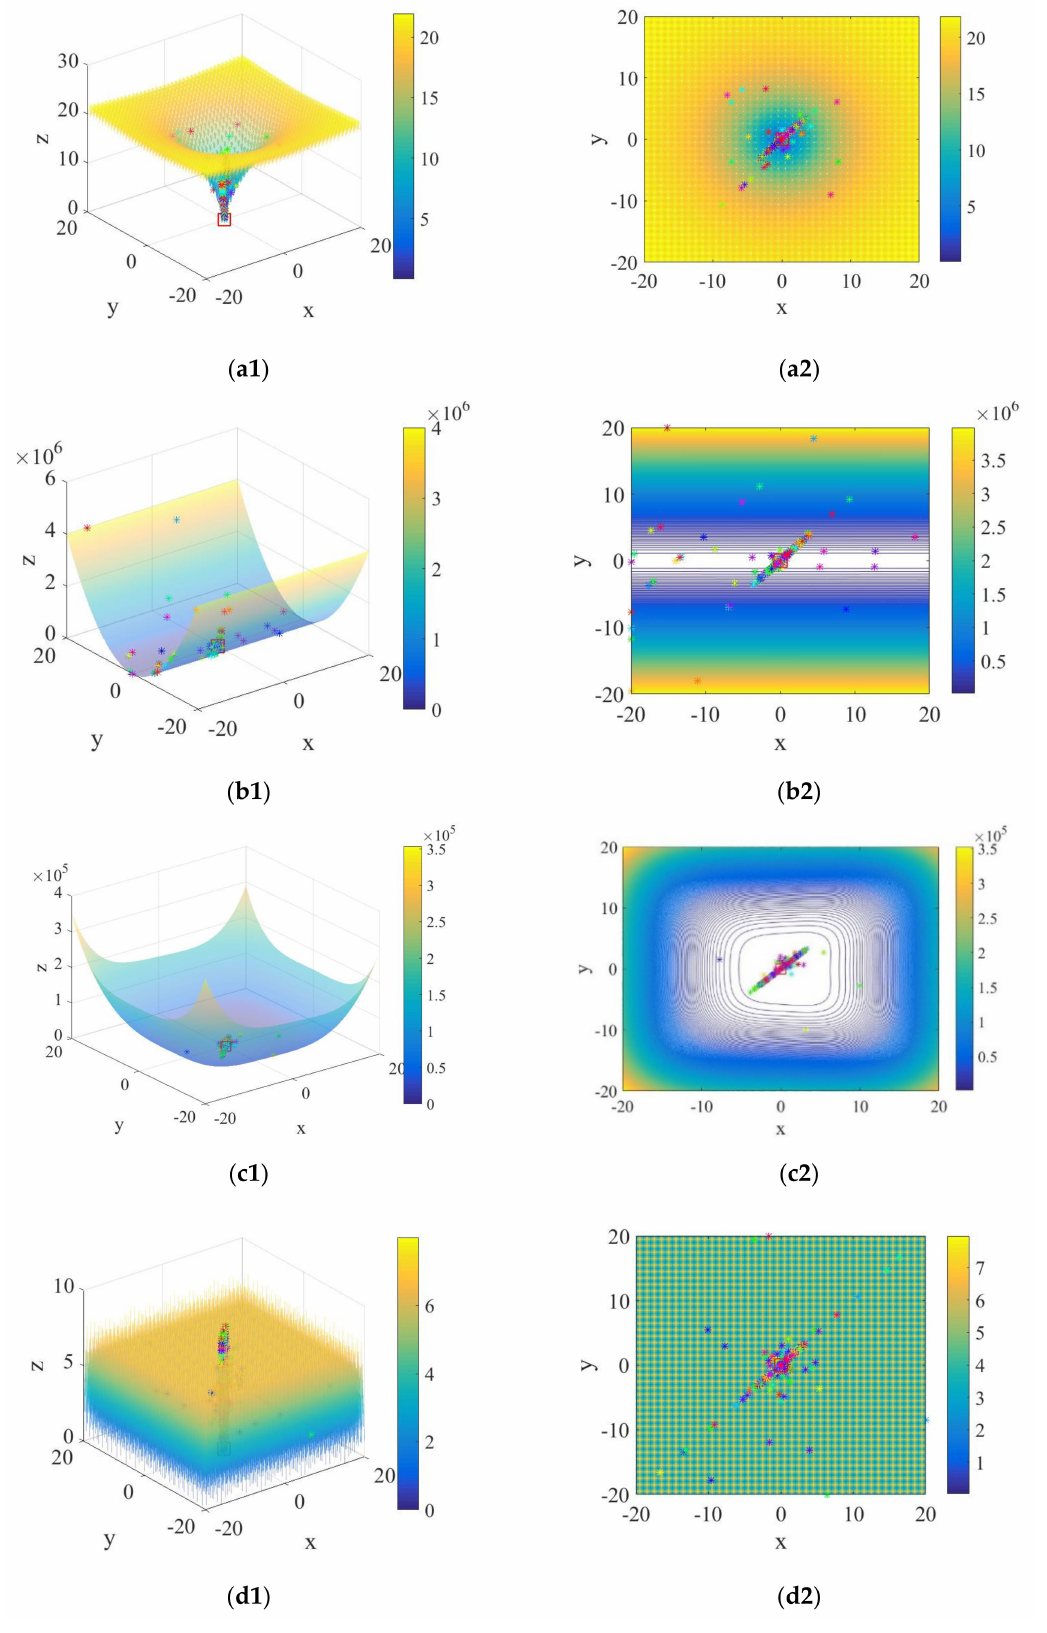
Figure 4. The trajectories of CASSA on the 3-D version of the four test functions: ( a1 , a2 ) Ackley function; ( b1 , b2 ) Cigar function; ( c1 , c2 ) Schwefel function; ( d1 , d2 ) Weierstrass